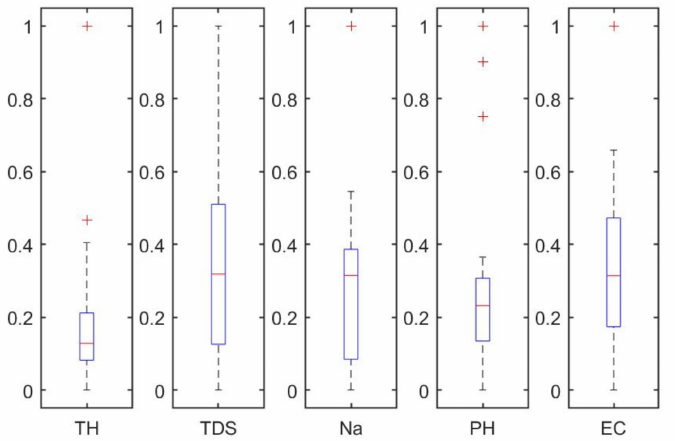
Figure 4. Box-plot representation of the variability of state variables (X 1 –X 5 ). Each box-plot identifies 25th, 50th (median), and 75th percentile scores. Whiskers correspond to the lowest observation within 1.5 of the interquartile range (IQR) of the lower quartile and to the highest observation still within 1.5 IQR of the upper quartile; crosses represent